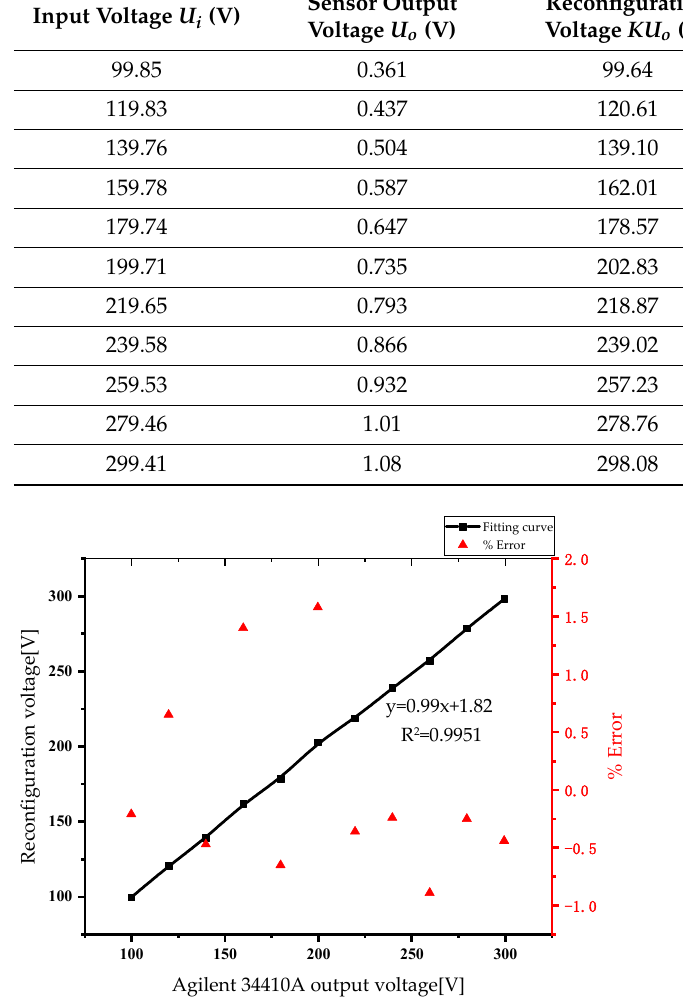
Table 2. Low voltage performance test input/output voltage and ratio error calculation results.